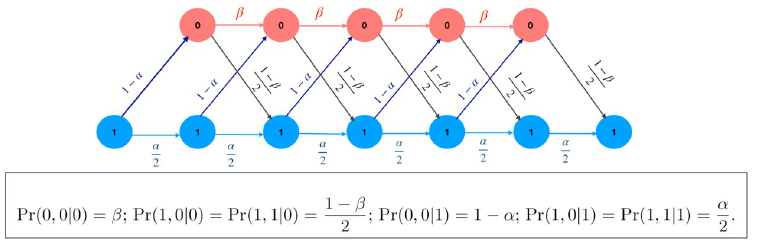
Fig 2. The trellis diagram used for illustrating how the MAP algorithm chooses the path of maximum a posteriori probability given a daughter sequence (1, 0 5 , 1). From each Markov state (0 or 1), there are two possible arrows to transition to the next state. The values P ð m arrow. Starting from state 1 at the left bottom, for each possible path moving along the arrows, one can compute the